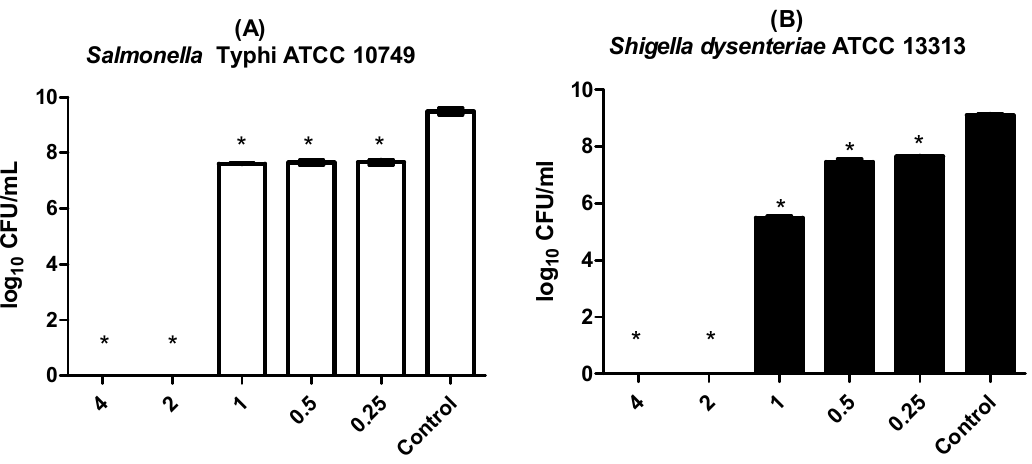
Figure 5. Effect of LaEO I on the eradication of Salmonella typhi ( A ) and Shigella dysenteriae ( B ) mature biofilm. Values are expressed as the mean ± SEM of two assays, in triplicate. The analysis was performed by ANOVA, with Dunnett’s post-test and p value < 0.05 (*) when compared to the control. Control: culture medium + microorganism.